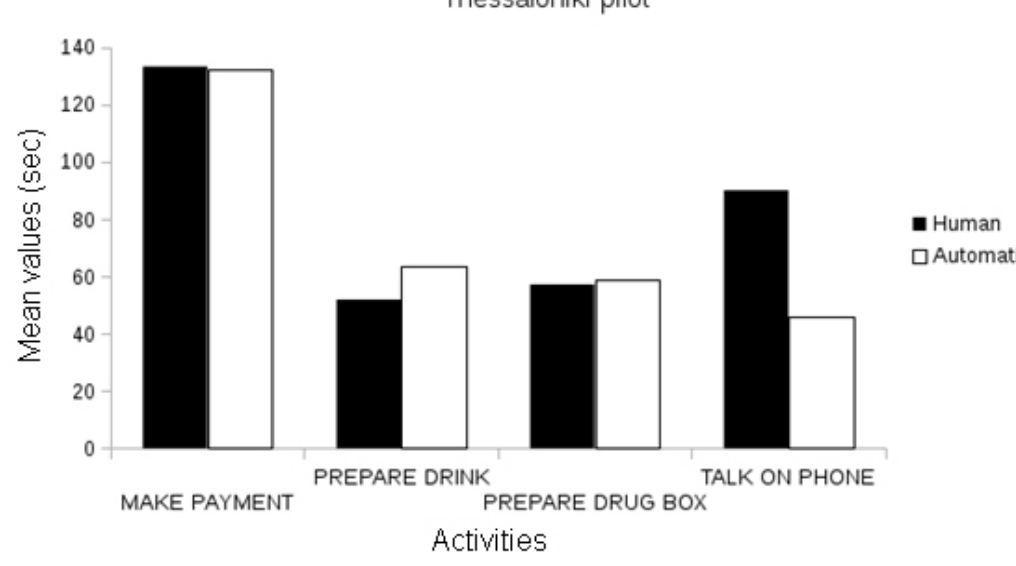
Figure 7. Comparison between the assessed duration (in seconds) of automatically recognized events and ground-truth data in the Thessaloniki Pilot.